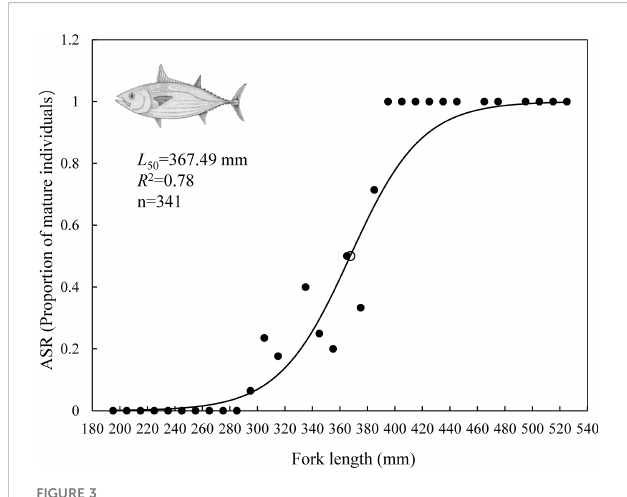
FIGURE 3 Proportions of mature skipjack tuna and logistic curves fi tted using the ASR model. Solid points represent observed data, and the circle represents the estimated mean fork length at 50% sexual maturity ( L 50 ).